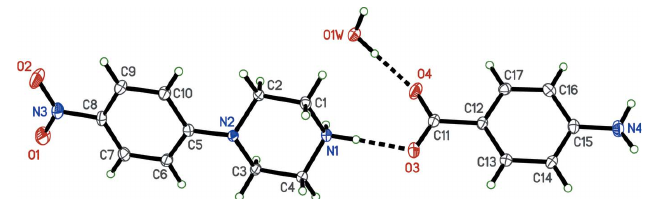
Figure 2 The molecular structure (50% displacement ellipsoids) of II . Hydrogen atoms are shown as arbitrary circles. The dashed lines indicate hydrogen bonds.